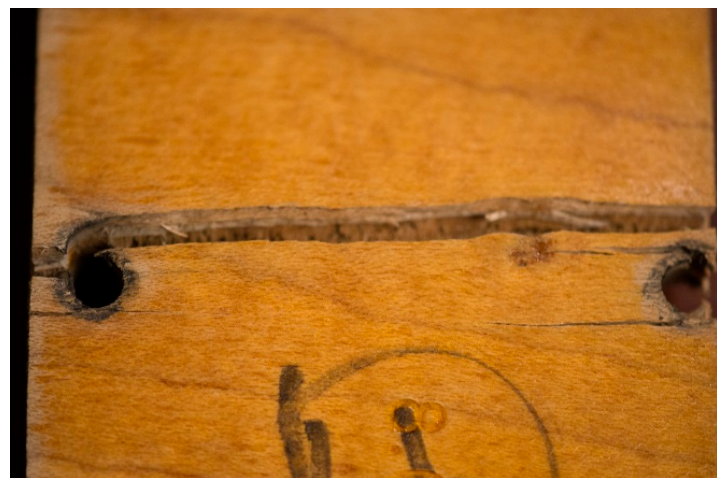
Figure 19. Top View Showing Splitting in Sample 1.